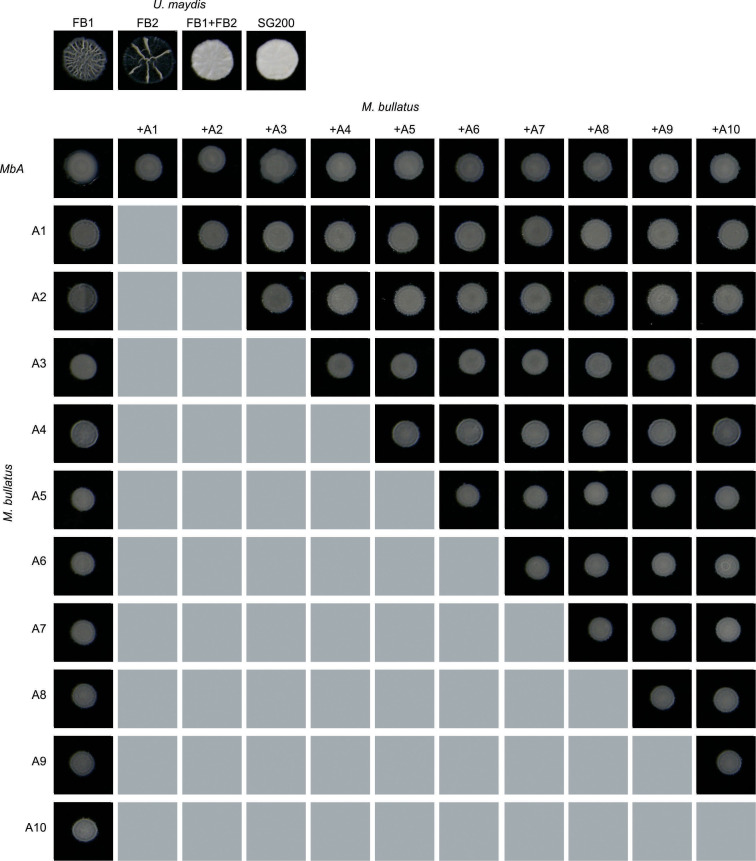
Mating assays of MbA and different M. bullatus isolates.Mixing of haploid U. maydis strains FB1 and FB2 and the solopathogenic strain SG200 served as a positive control for mating on charcoal plates, wherein filamentous growth is indicated by white, fluffy appearance of colonies. Haploid wild-type strains without mating partner do not show a fluffy phenotype. For all combinations of Moesziomyces strains, no mating event resulting in filamentous growth on charcoal plates was observed.